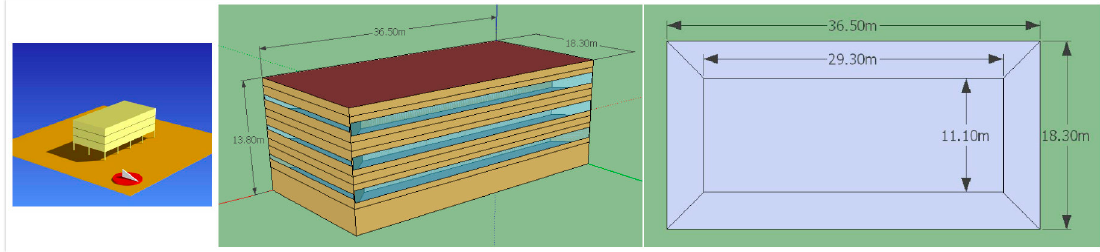
Figure 2. Building model geometry and zone division.